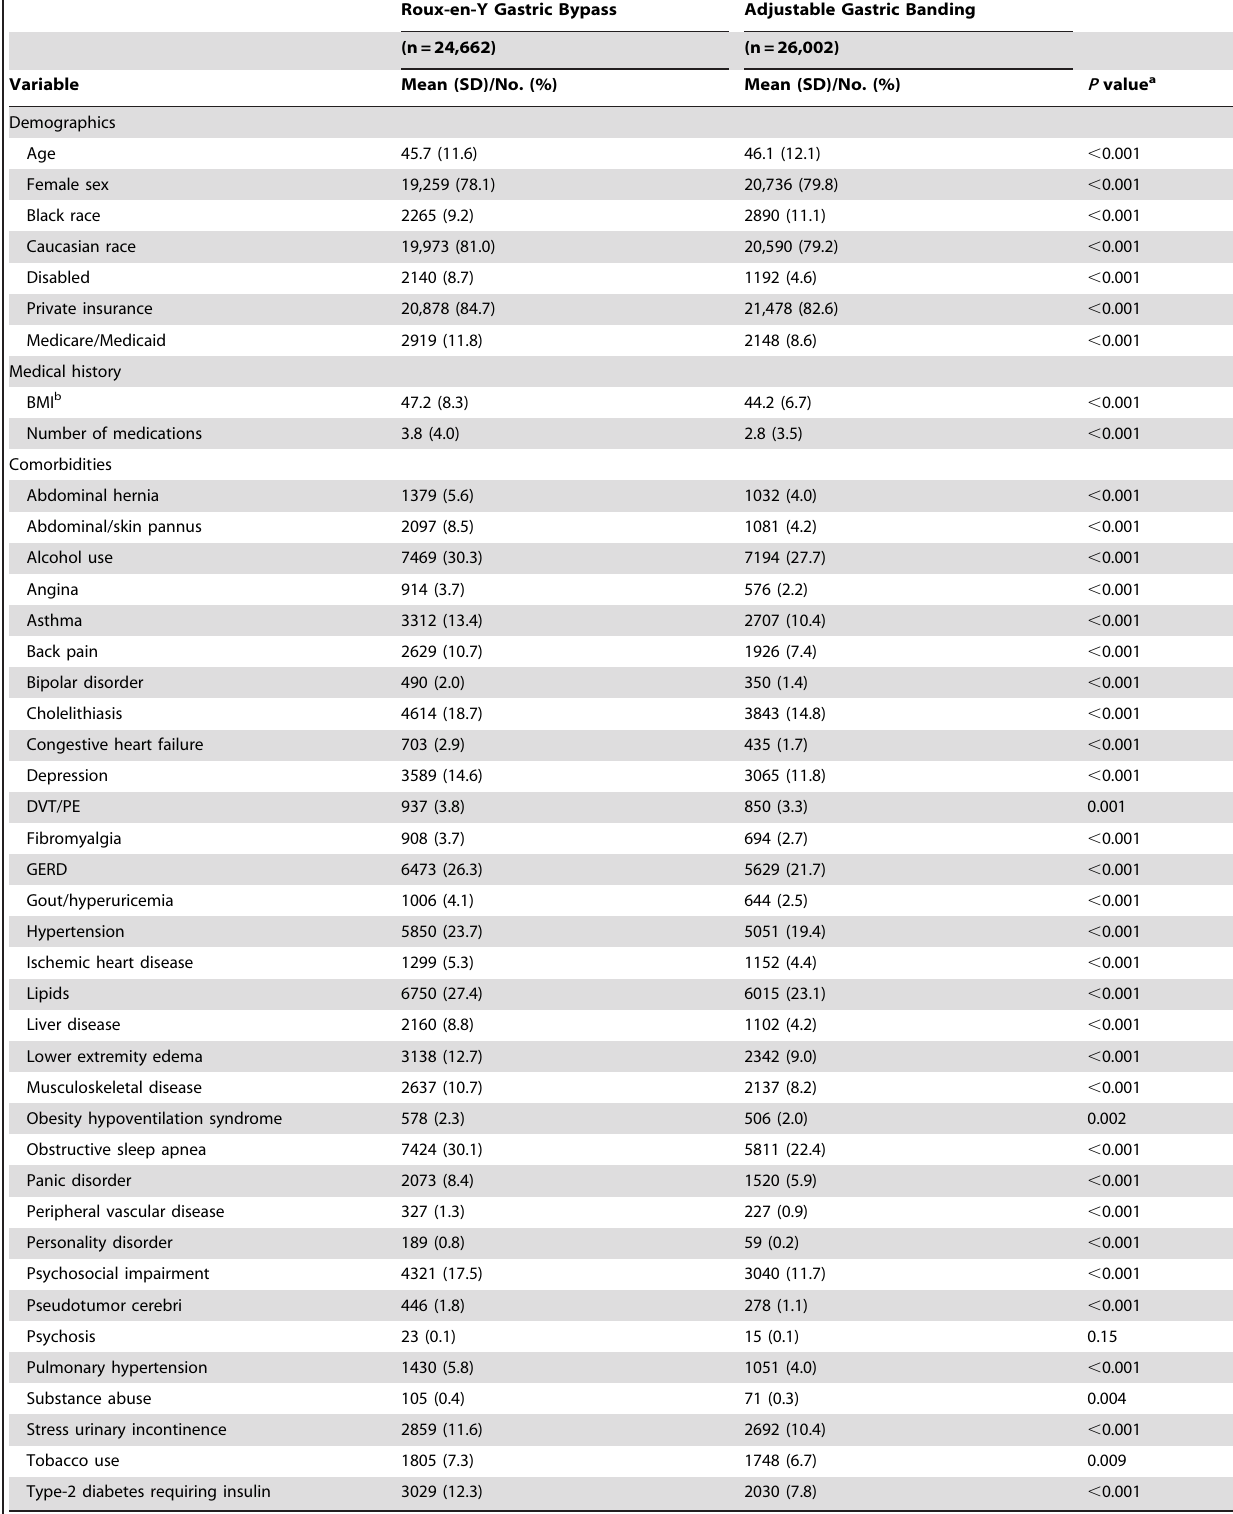
Table 2. Characteristics of Study Participants by